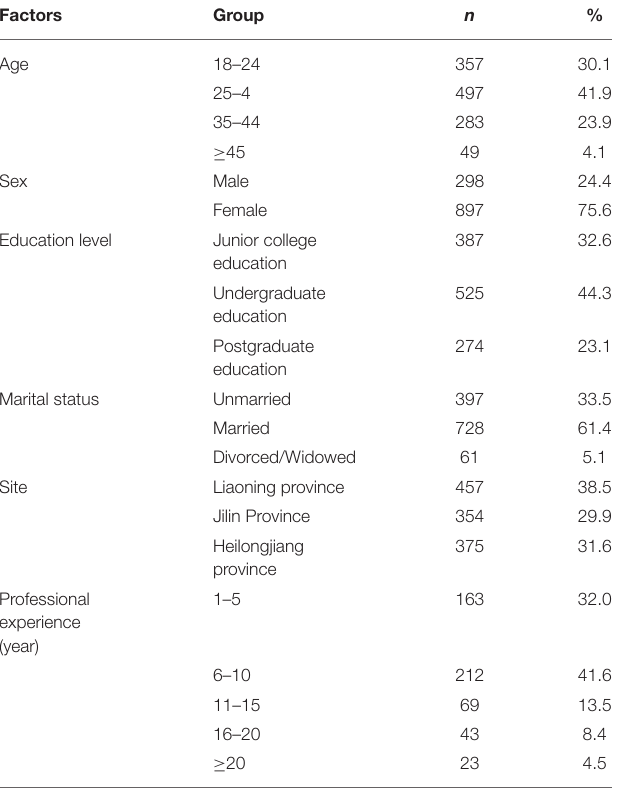
TABLE 1 | Frequency distribution of demographic characteristics ( n = 1,186). TABLE 2 | Item analysis for Chinese version of the occupational low back pain